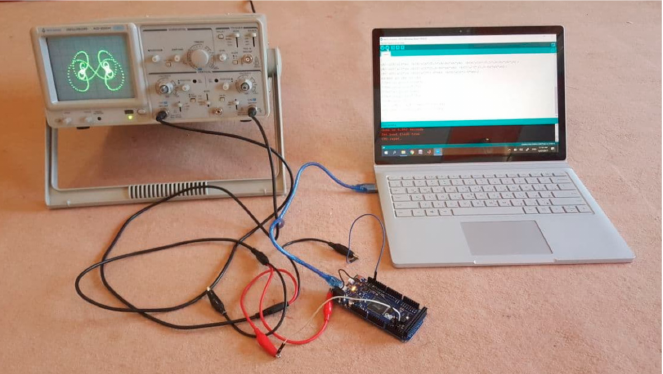
Figure 10. Hardware implementation of the system in Equation (5) based on Arduino Due board.